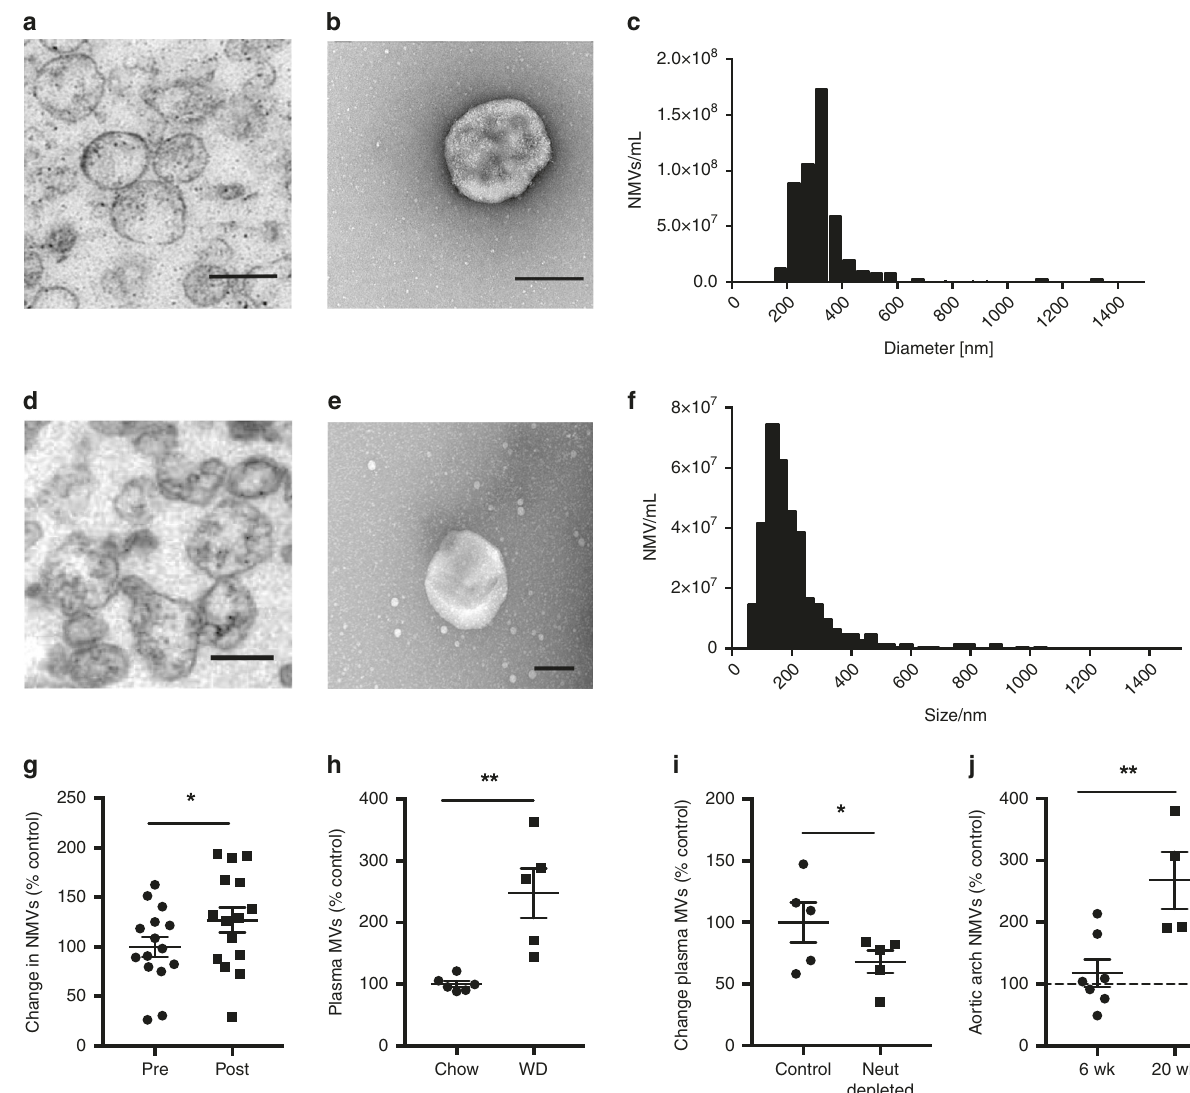
Fig. 1 Hypercholesterolaemia promotes NMV release and accumulation in the vessel wall. NMVs were prepared from stimulated human ( a – c ) or mouse ( d – f ) neutrophils. a , d Transmission electron micrograph of an NMV pellet. b , e Transmission electron micrograph of a negatively stained NMV sample on carbon-coated copper grids. Magni fi cation of both micrographs ×28,500. Scale bars = 0.25 µ m ( a ), 0.2 µ m ( b ), 0.25 µ m ( c ), 0.2 µ m ( d ). Representative histogram showing size distribution of human ( c ) and mouse ( f ) NMVs analysed using Tunable Resistive Pulse Sensing and Nanoparticle Tracking Analysis, respectively. g NMVs were detected in human plasma samples before and after high-fat diet using fl ow cytometry by staining with FITC-anti- CD66b ( n = 15). h Total plasma MVs in ApoE − / − mice fed chow ( n = 6) or high-fat diet for 6 weeks ( n = 5) and i in ApoE − / − mice fed high-fat